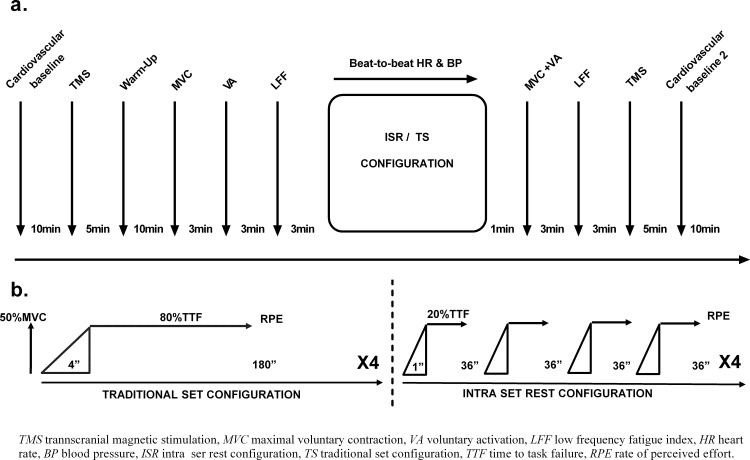
Schematic representation of the experimental protocol.(a) time line of measurements. (b) the training protocols performed in each session,. Each protocol (TS/ISR) utilized the same intensity, total muscle contraction and rest time.